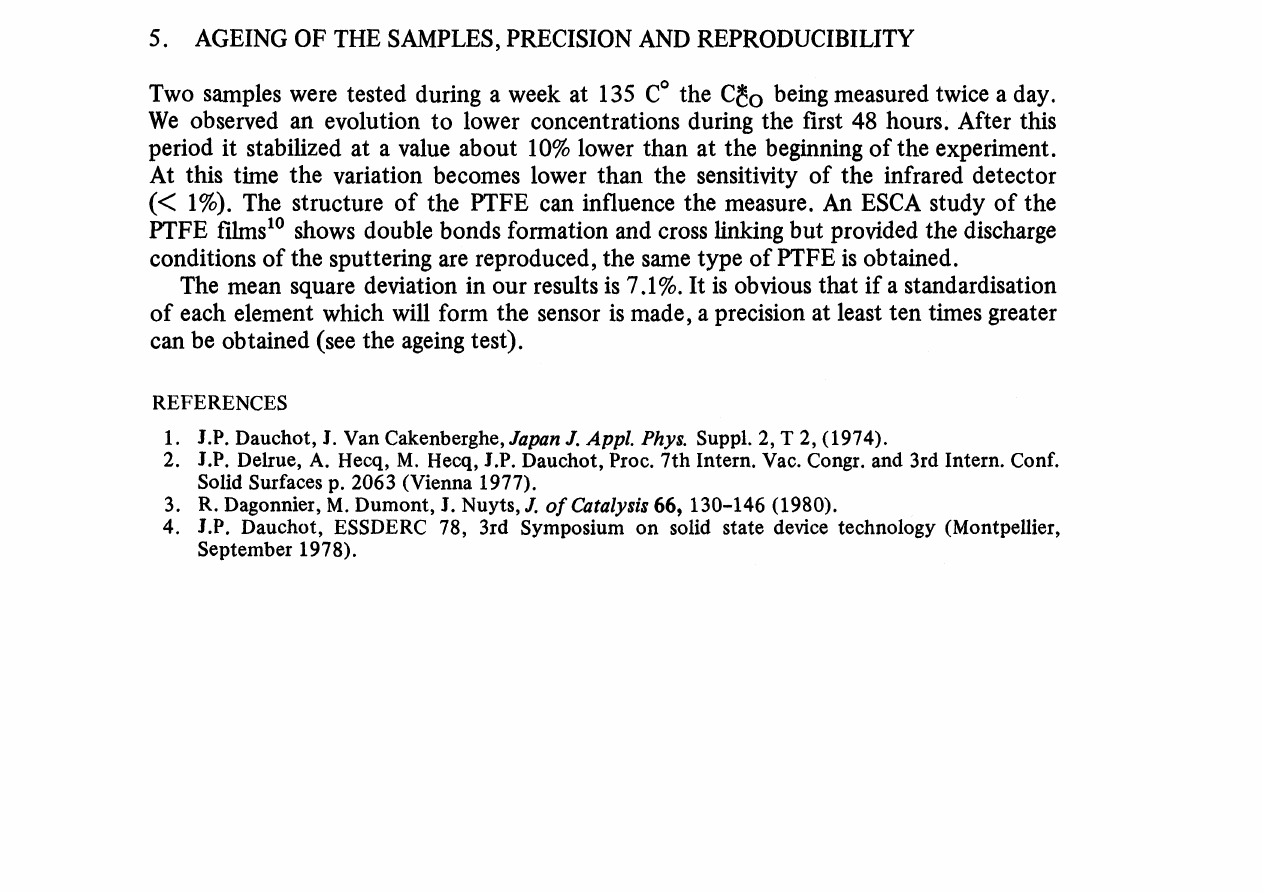
FIGURE 6 Relative resistance variation recorded versus the [CO]/[O2] ratio for different membrane